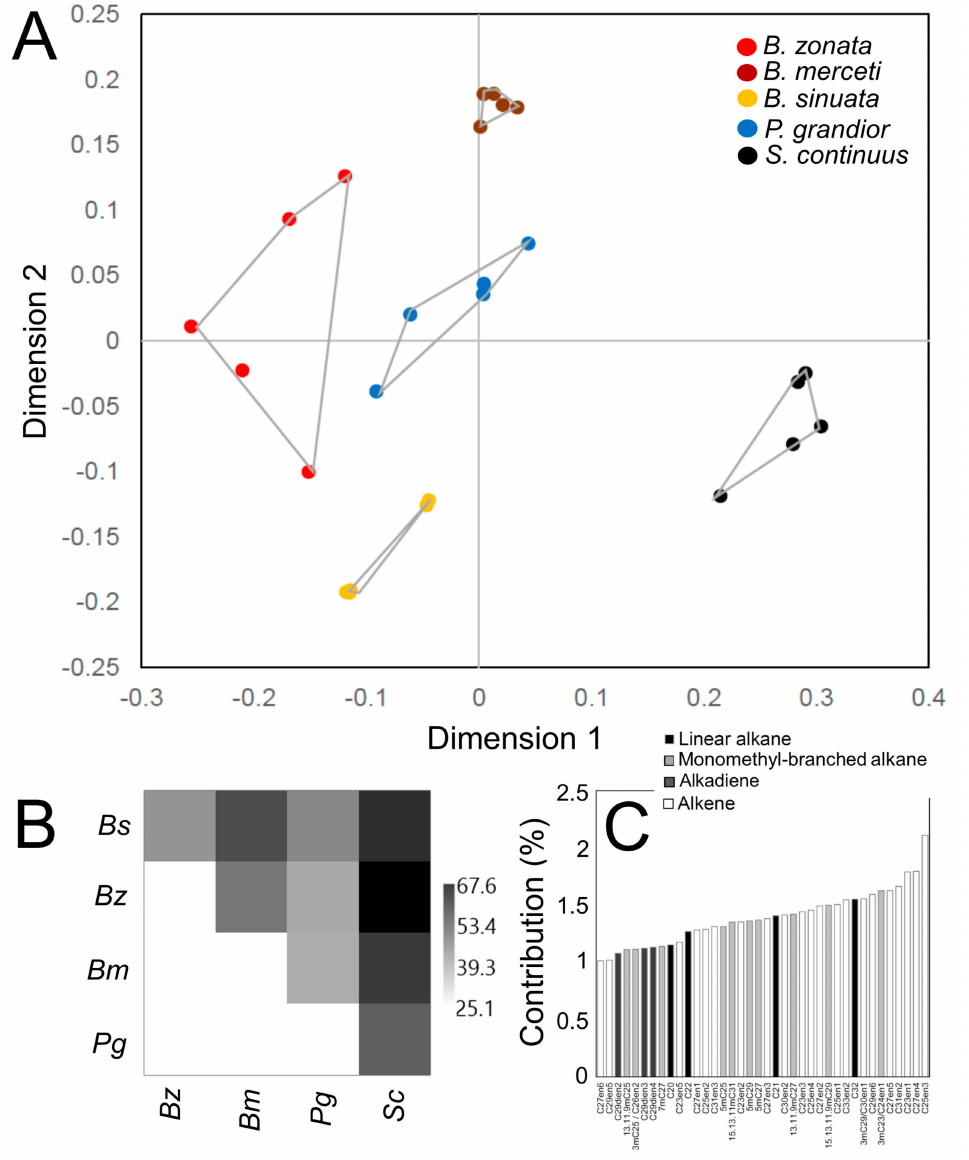
Figure 4. ( A ) Non-metric multidimensional scaling (NMDS) based on Bray-Curtis distances of all individual CHC profiles of P. grandior , its Bembix hosts, and the non-host S. continuus . ( B ) Matrix plot showing SIMPER (similarity percentages) dissimilarities among all the studies species. ( C ) Histogram showing all substances with > 1% contribution to the SIMPER dissimilarity among the studied species and their relative amount contributing to CHC profiles; white, light grey, dark grey and black bars correspond to substances of di ff erent groups (alkenes, mono- and dimethyl-branched alkanes, alkadienes and linear alkanes). Bs = B. sinuata , Bz = B. zonata , Bm = B. merceti , Pg = P. grandior , Sc = S. continuus